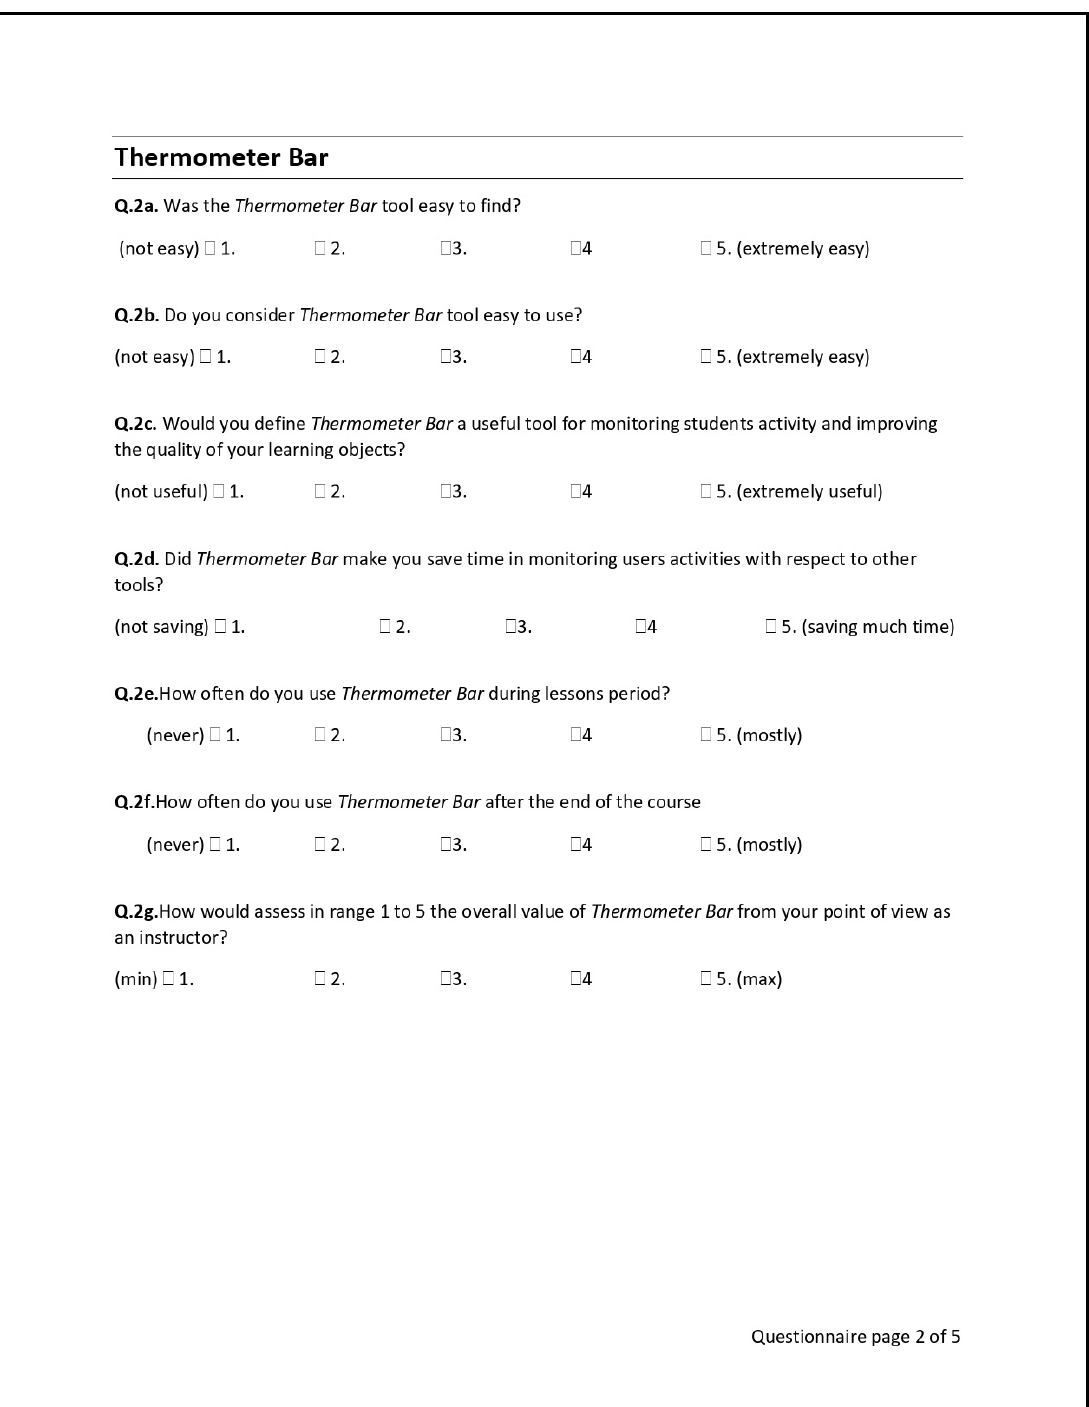
Figure A2. Questionnaire page 2 of